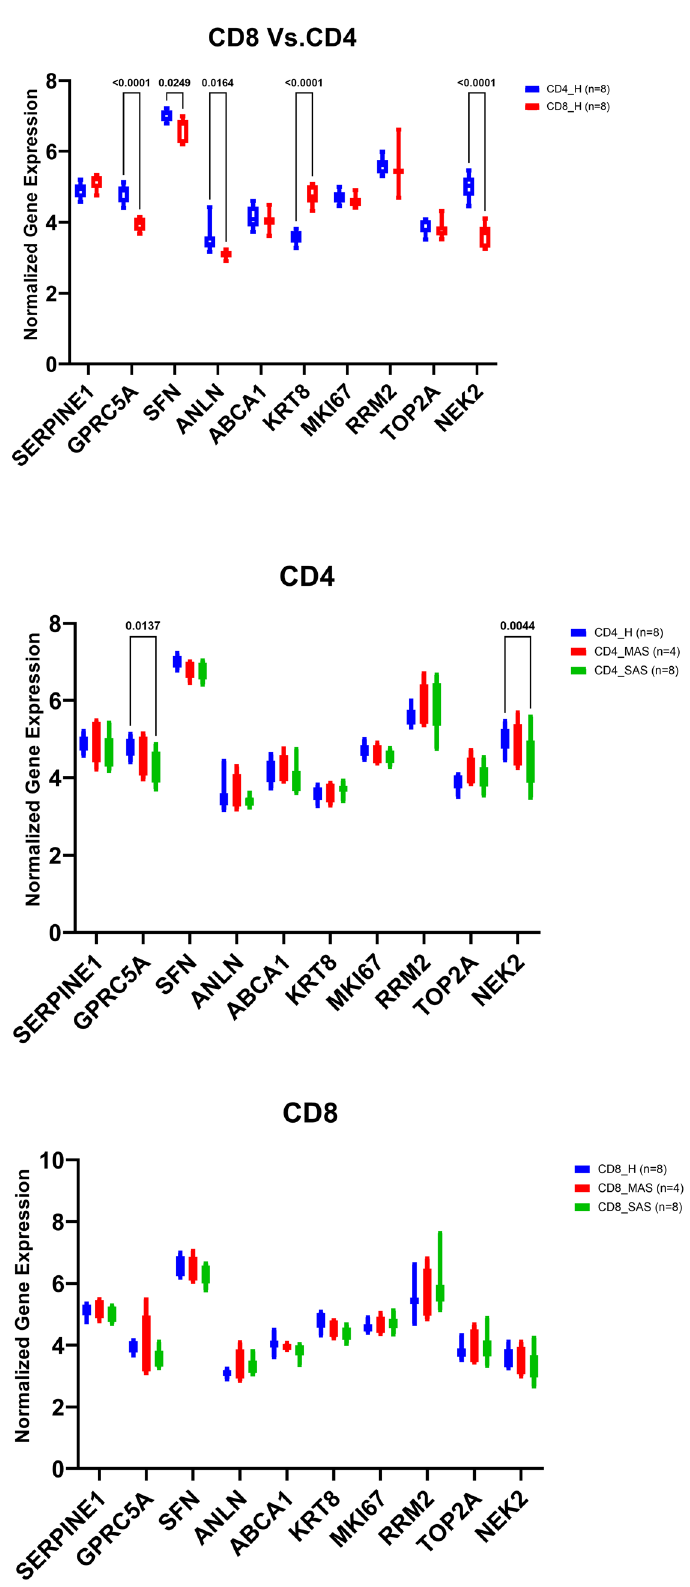
Figure 5. Normalized gene expression of genes identified in circulating T-cells (CD4 versus CD8) of asthmatic patients “MAS = mild to moderate and SAS = severe” compared to healthy (H) controls extracted from the expression profile of publicly available datasets